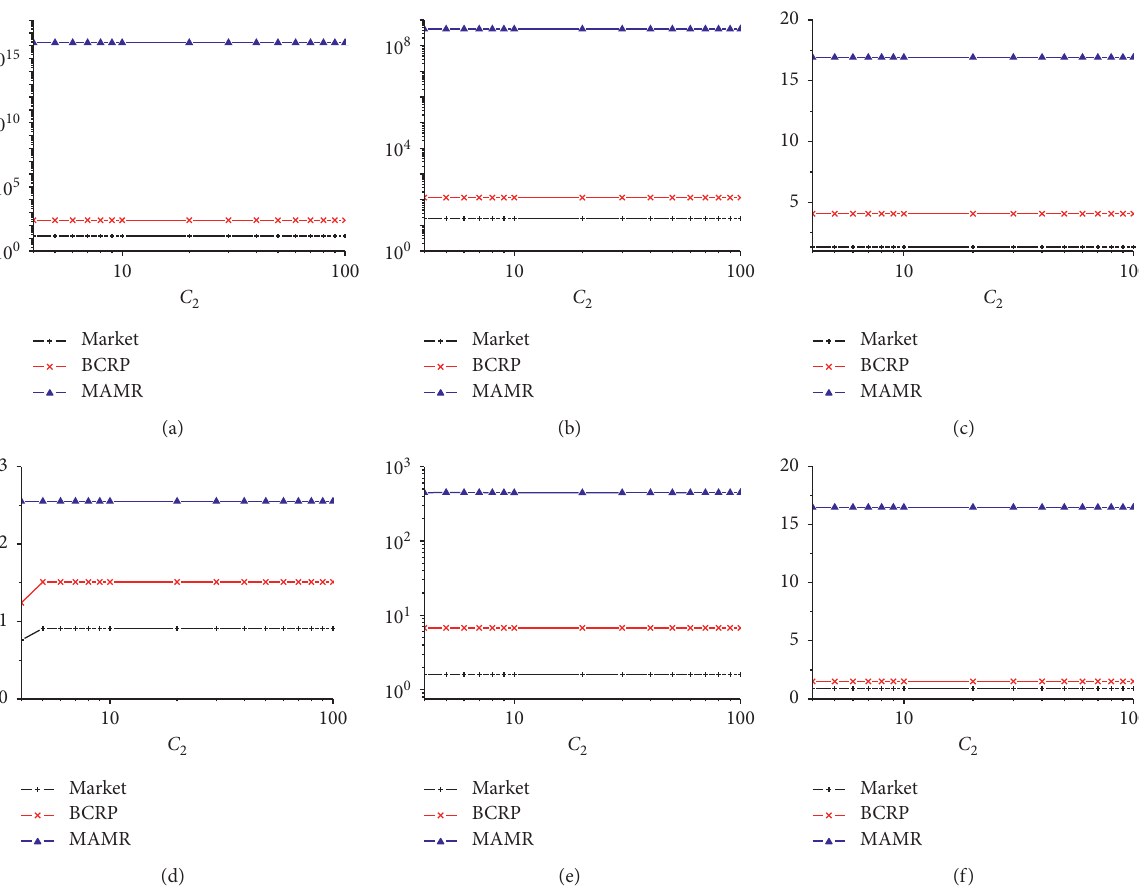
� 3. (a) NYSE(O). (b) NYSE(N). (c) SP500. (d) 1